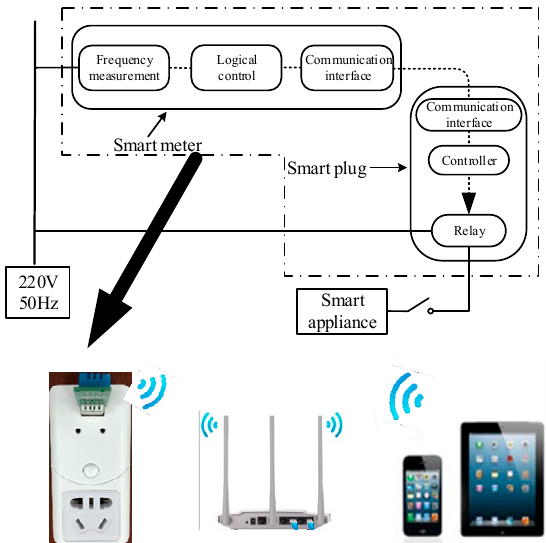
Figure 5. Control unit of an intelligent appliance.